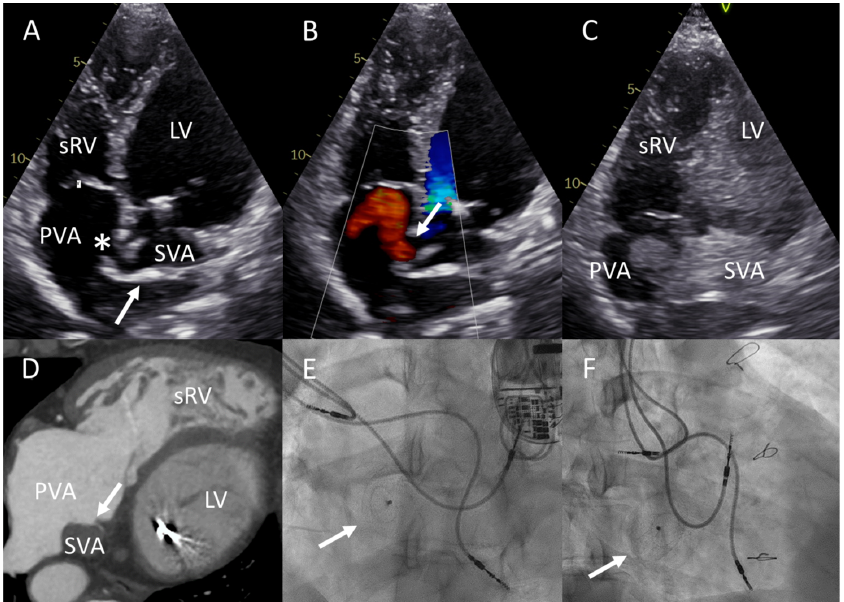
Figure 2. Baffle leak visualization and closure in patient B. ( A ) Apical four chamber view shows that the atrial baffle (arrow) directs systemic venous return atrium (SVA) to the subpulmonary left ventricle (LV) and the pulmonary venous return atrium (PVA) to the systemic right ventricle (sRV). The baffle leak is indicated by an asterisk (*). ( B ) Color Doppler apical four chamber view demonstrates SVA to PVA shunting through the baffle leak. ( C ) Significant interatrial shunting confirmed by agitated saline contrast echocardiography. Note the contrast opacification of the SVA and subpulmonary LV, and the jet crossing the baffle leak into the PVA. ( D ) Axial slice through a computed tomography scan at the level of the atria shows the baffle leak (arrow). ( E , F ) Left anterior oblique and right superior oblique fluoroscopy projections, respectively show the Occlutech Figulla Flex II Atrial Septal Defect (ASD) Occluder (arrow) projecting over the interatrial baffle. Note the presence of one ventricular (LV) and two atrial (SVA) pacemaker